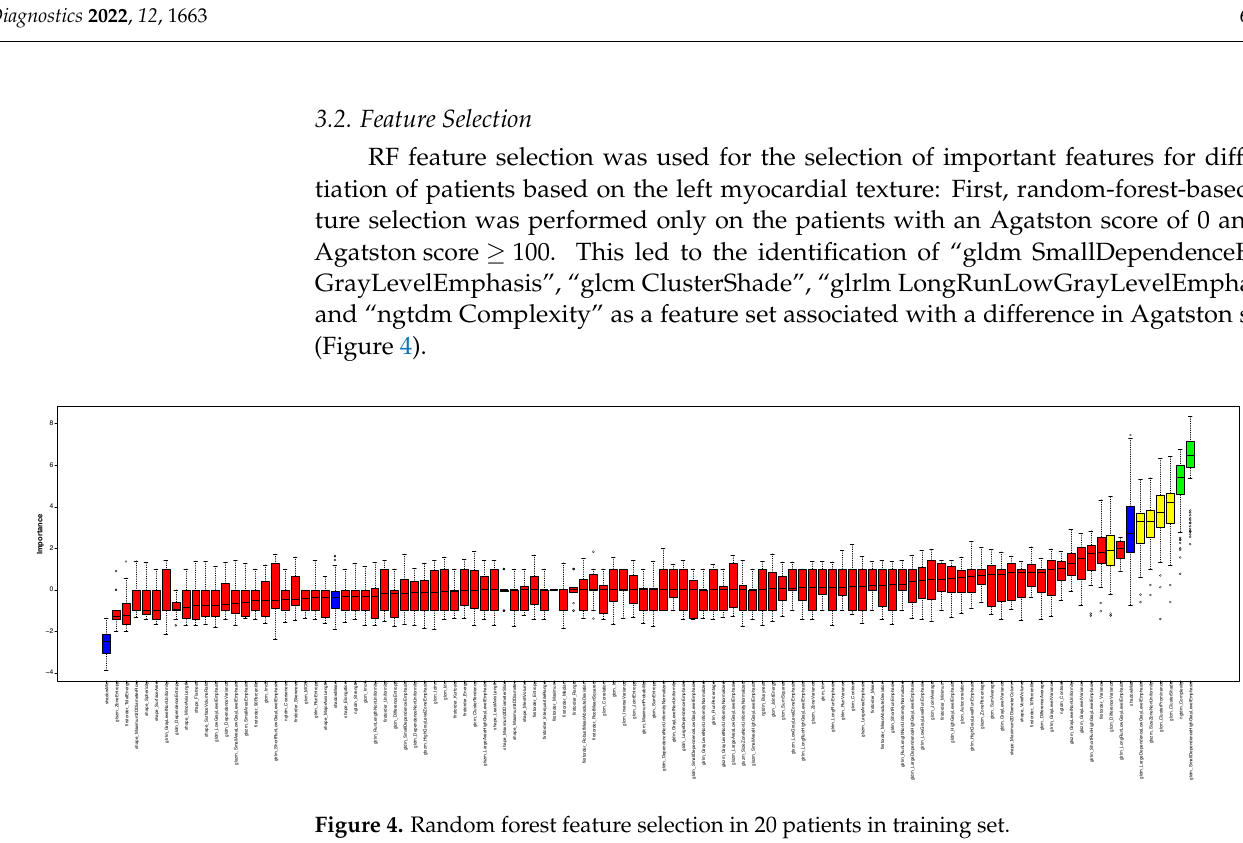
Figure 4. Random forest feature selection in 20 patients in training set.